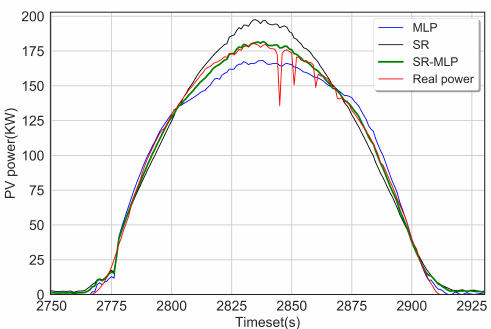
Figure 11. One-day PV power forecasting using the different models (kW) (high resolution).